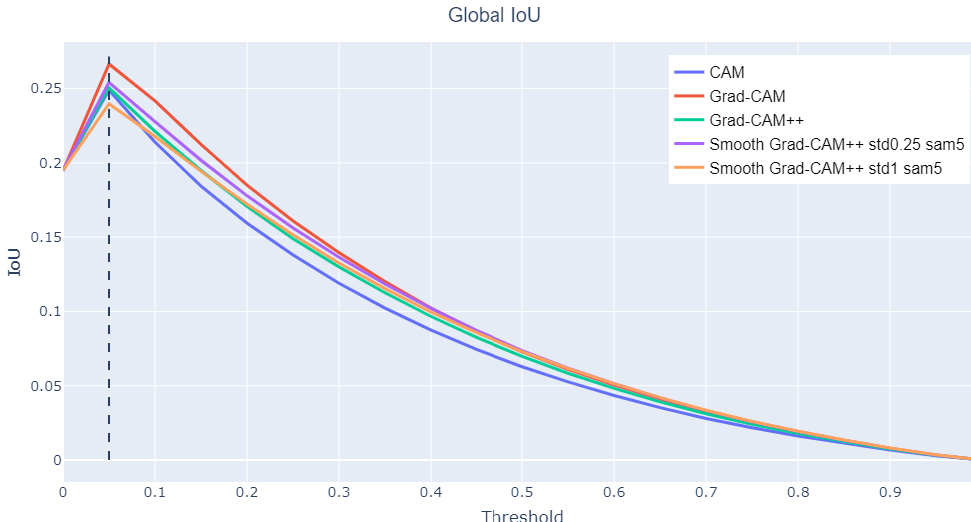
Figure 8. Global IoU at varying threshold levels.